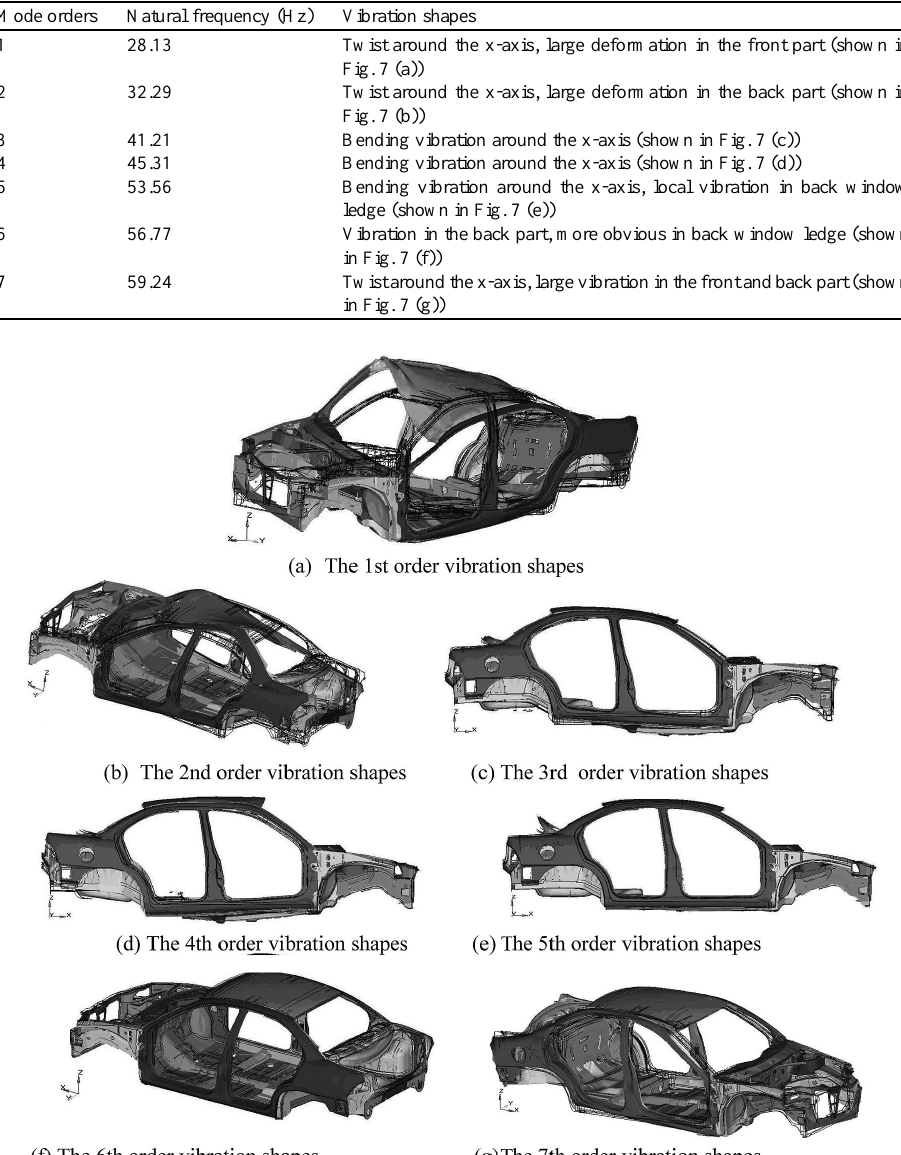
Table 4 Modal description of BIW with finite element model